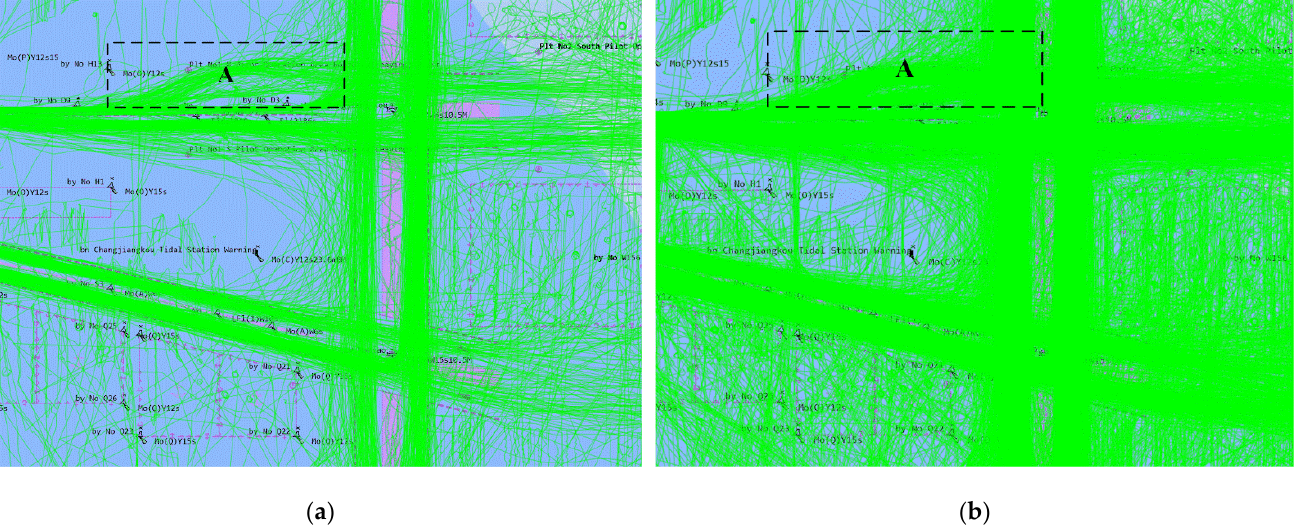
Figure 4. Chart of the Yangtze River Estuary.